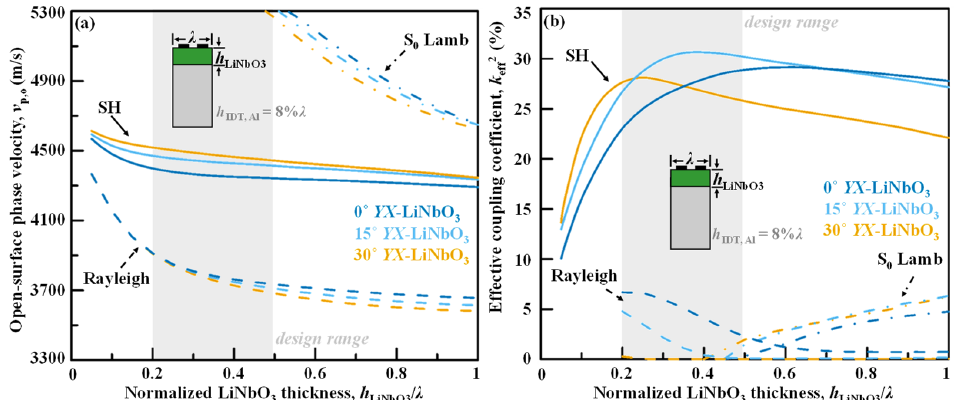
Figure 3. Calculated dispersion curves of ( a ) open-surface phase velocities v p,o and ( b ) effective coupling coefficient k eff2 for the LiNbO 3 /Si with varied rotation angle of YX -LiNbO 3